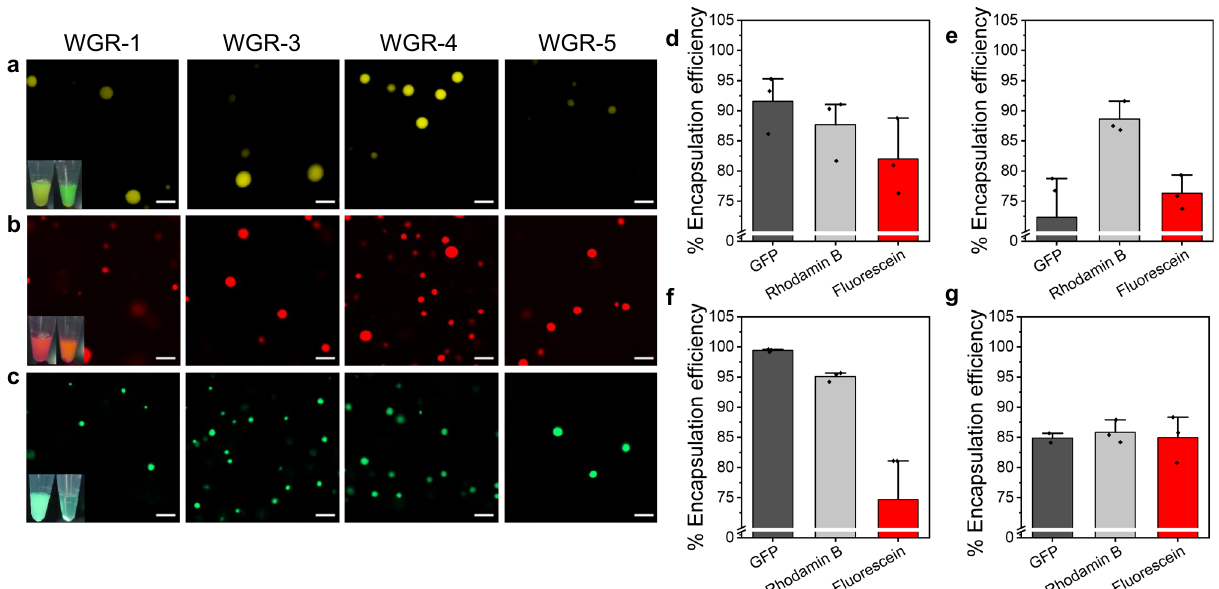
Fig. 4 | Partitioning of fl uorescent payloads within droplets depends on pep- tidepolarity. Confocalmicroscopyimagesof( a ) fl uorescein,( b )RhodamineBand ( c ) GFP partitioning within WGR-1, WGR-3, WGR-4, and WGR-5 peptide droplets. Scalebar=10 μ m.Insets:Macroscopicimagesofthepartitioningofthe fl uorescent payload in peptide droplets samples before (left) and after (right) centrifugation